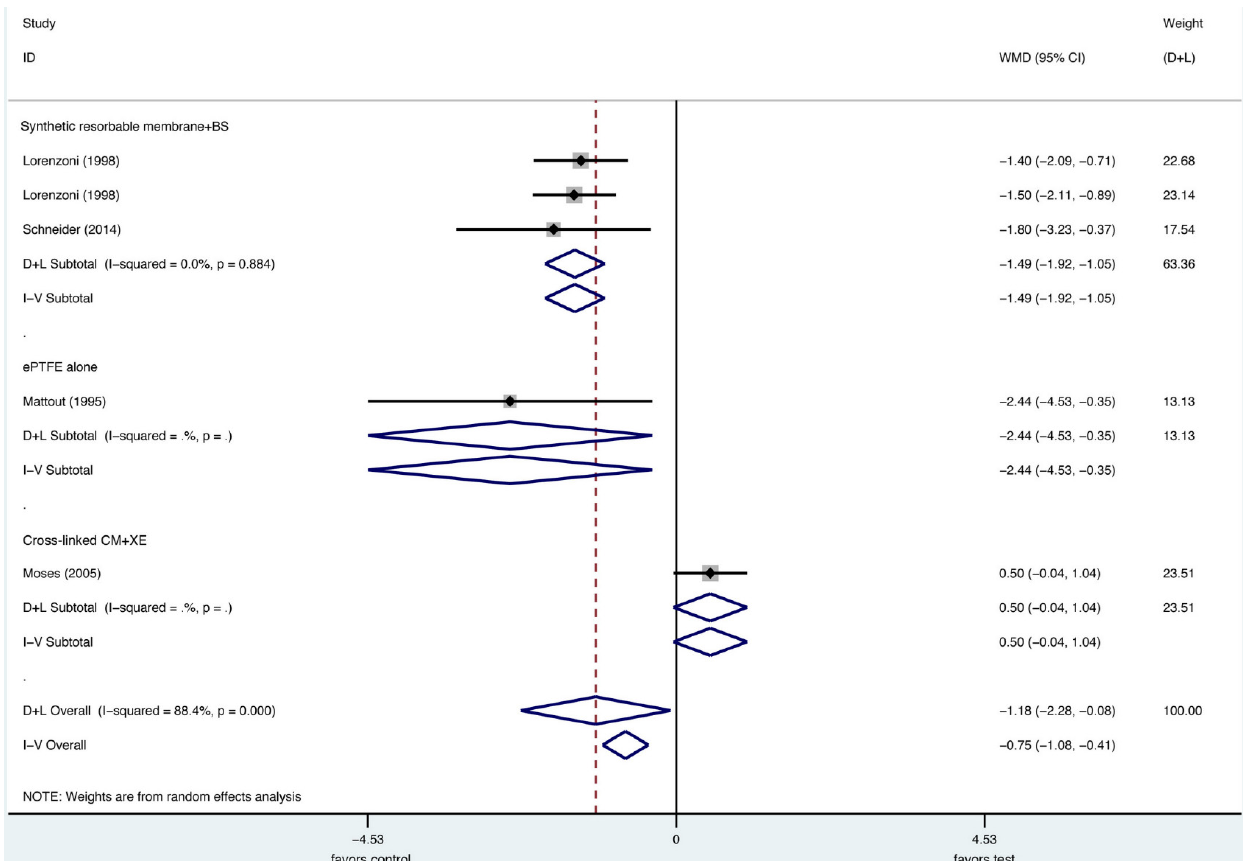
Figure 2. Forest plot illustrating the results in terms of defect height reduction from the meta-analysis of all trials with a non-resorbable expanded polytetrafluorethylene membrane in combination with any bone substitute (ePTFE + BS) as a control. CM: collagen membrane. (From Thoma, DS, Bienz, SP, Figuero, E, Jung, RE, Sanz-Martín, I. Efficacy of lateral bone augmentation performed simultaneously with dental implant placement: A systematic review and meta-analysis. J Clin Periodontol . 2019; 46(Suppl. 21): 257–276. With permission).